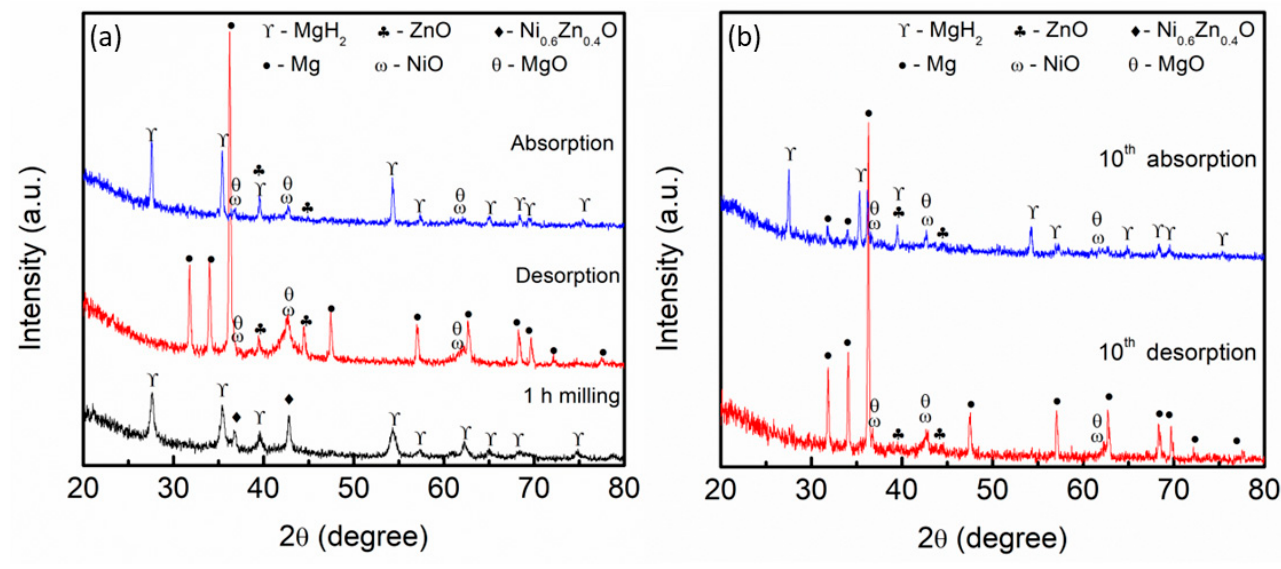
Figure 10. XRD pattern of MgH 2 –10 wt.% Ni 0.6 Zn 0.4 O samples ( a ) after 1st cycle and ( b ) after 10th cycle.